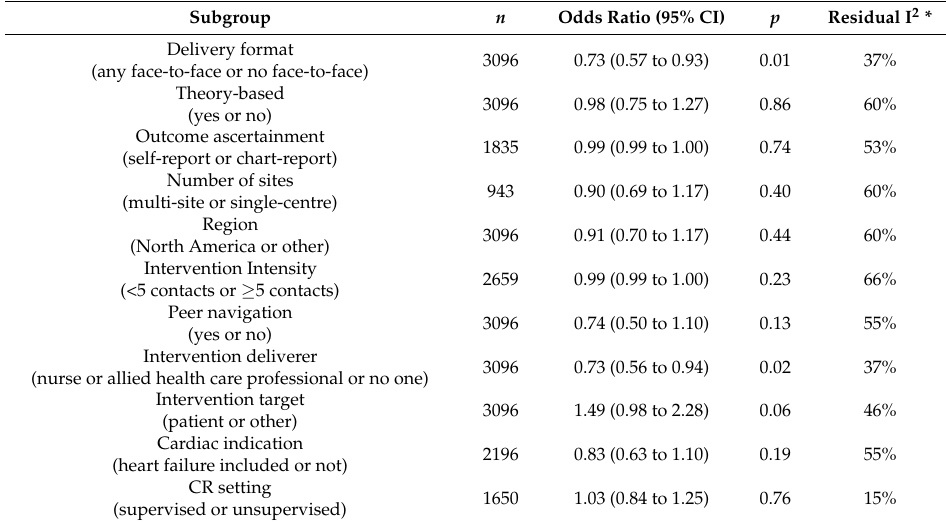
Table 2. Meta-regression results for